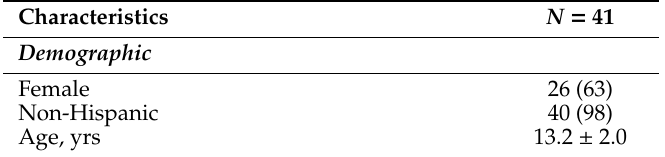
Table 1. Demographic and Cardiometabolic Phenotype Characteristics in Black